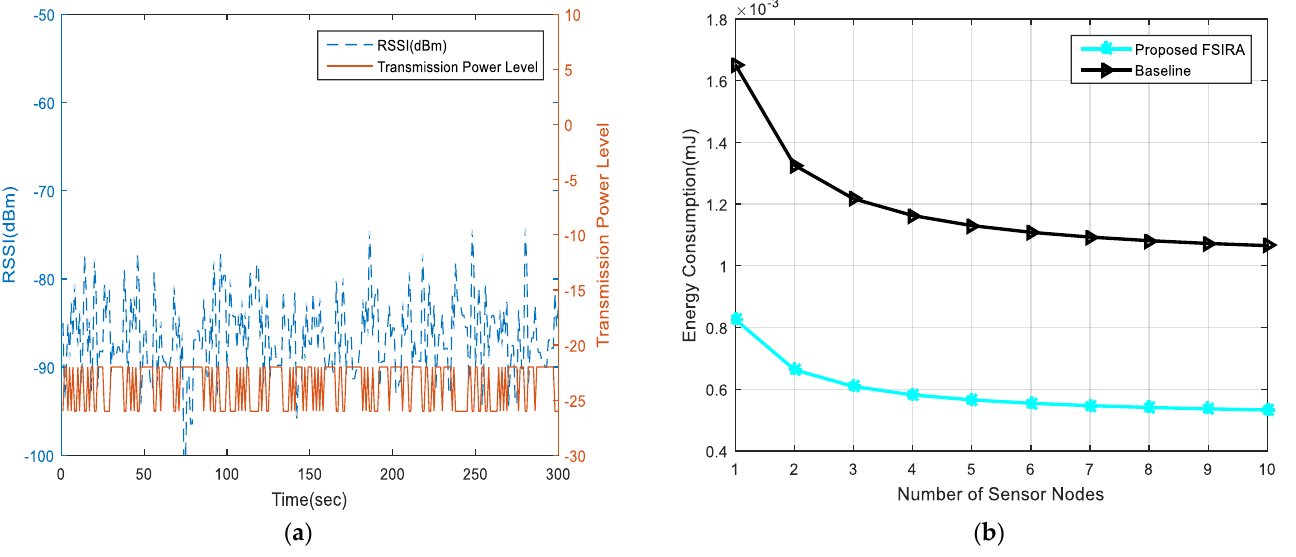
Figure 8. Analysis of ( a ) reliability, ( b ) convergence in healthcare system.